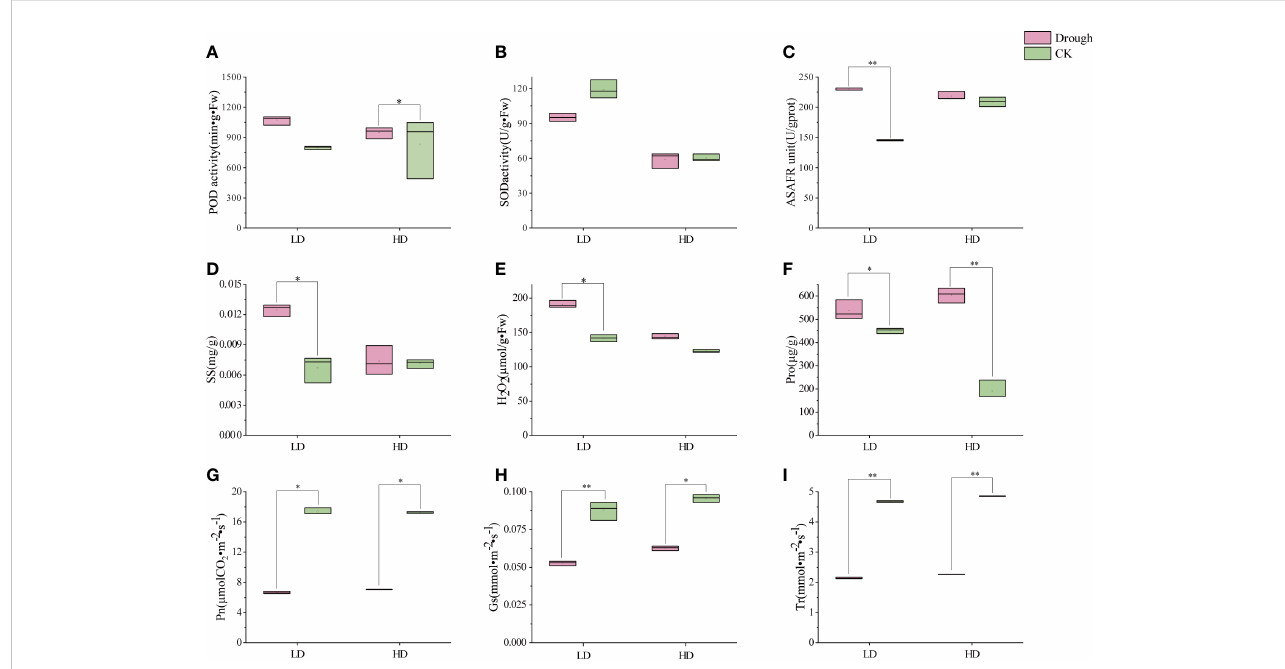
FIGURE 2 Antioxidant enzyme activities, ROS content, osmotic regulatory substance and photosynthetic characteristics under different drought treatment; (A) peroxidase activity (POD); (B) superoxide dismutase activity (SOD); (C) Anti-superoxide anion viability unit (ASAFR); (D) soluble sugars content (SS); (E) H 2 O 2 content; (F) proline content (Pro); (G) Net photosynthetic rate (Pn); (H) Stomatal conductivity (Gs); (I) Transpiration rate (Tr). * P <0.05, ** P